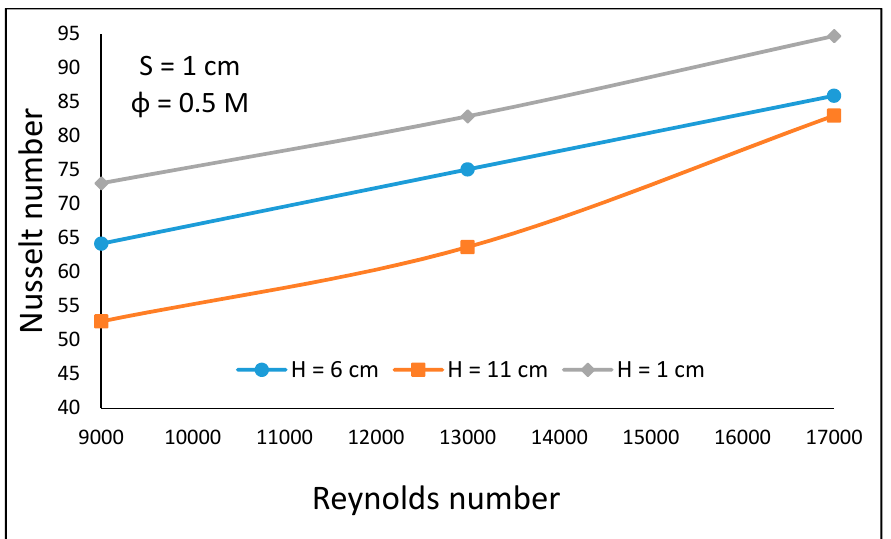
Figure 14. Interaction of Reynolds number and nozzle-plate distance levels at optimum levels of other factors at nozzle-nozzle spacing = 1 cm.